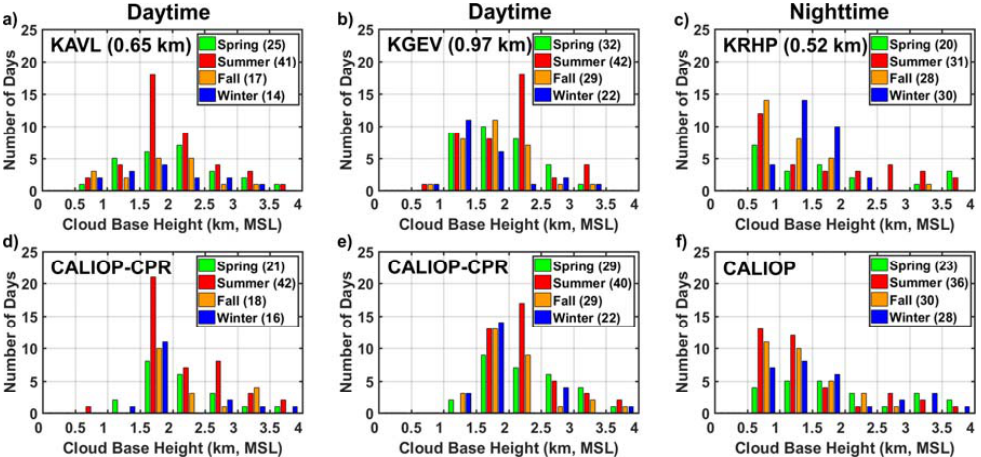
Figure 10. Probability distributions using 10-year (June 2006–October 2016) observations of CBHs from: ( a ) the ground ceilometer at KAVL (elevation: 0.65 km) around daytime overpass (~14:50